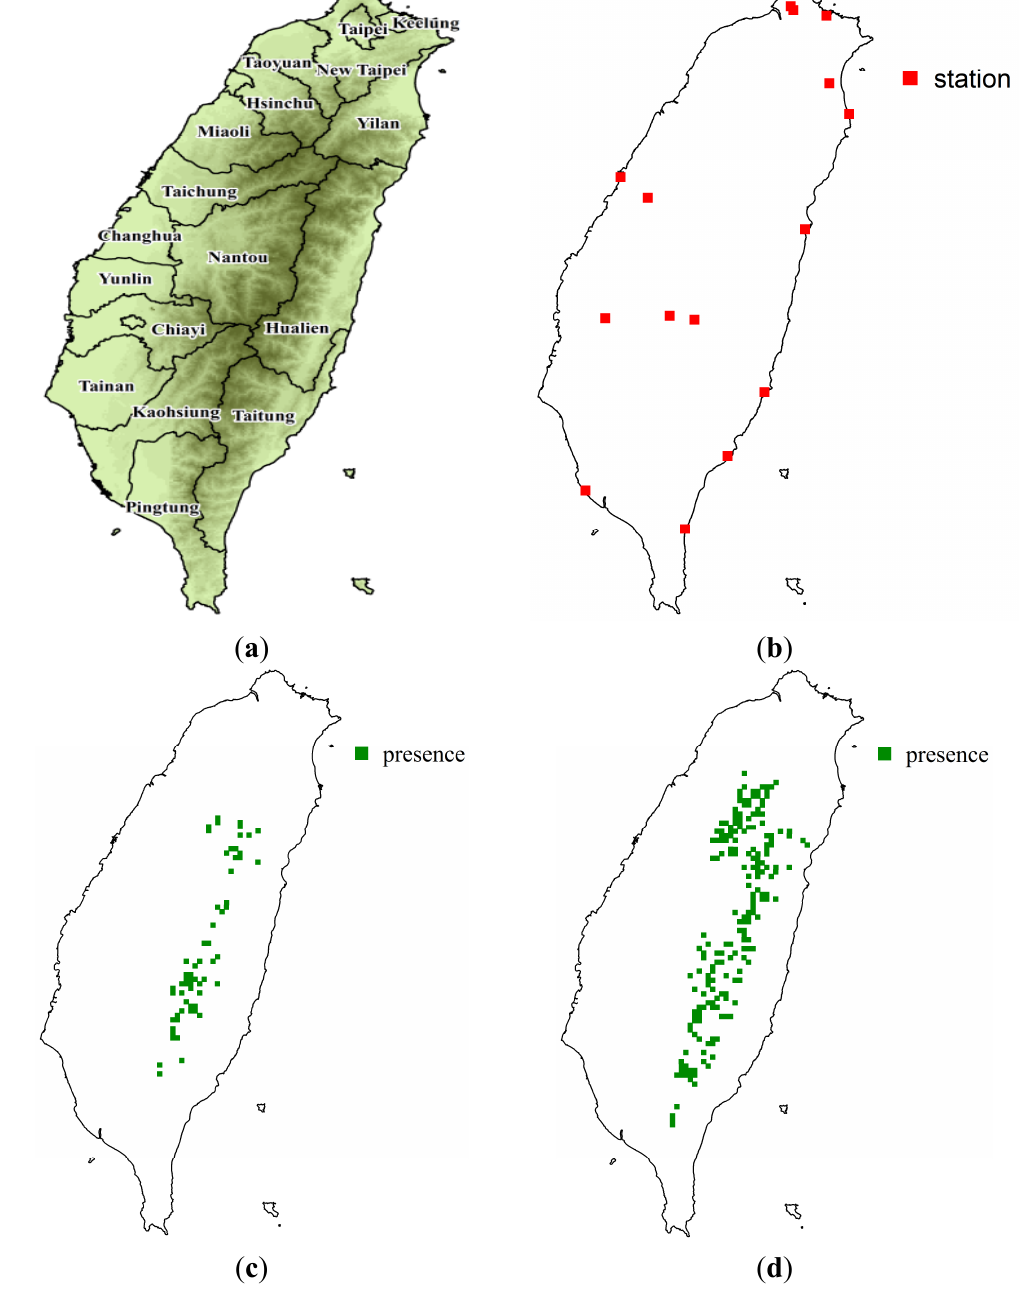
Figure 1. ( a ) The topography of Taiwan; ( b ) locations of weather stations; ( c ) sample